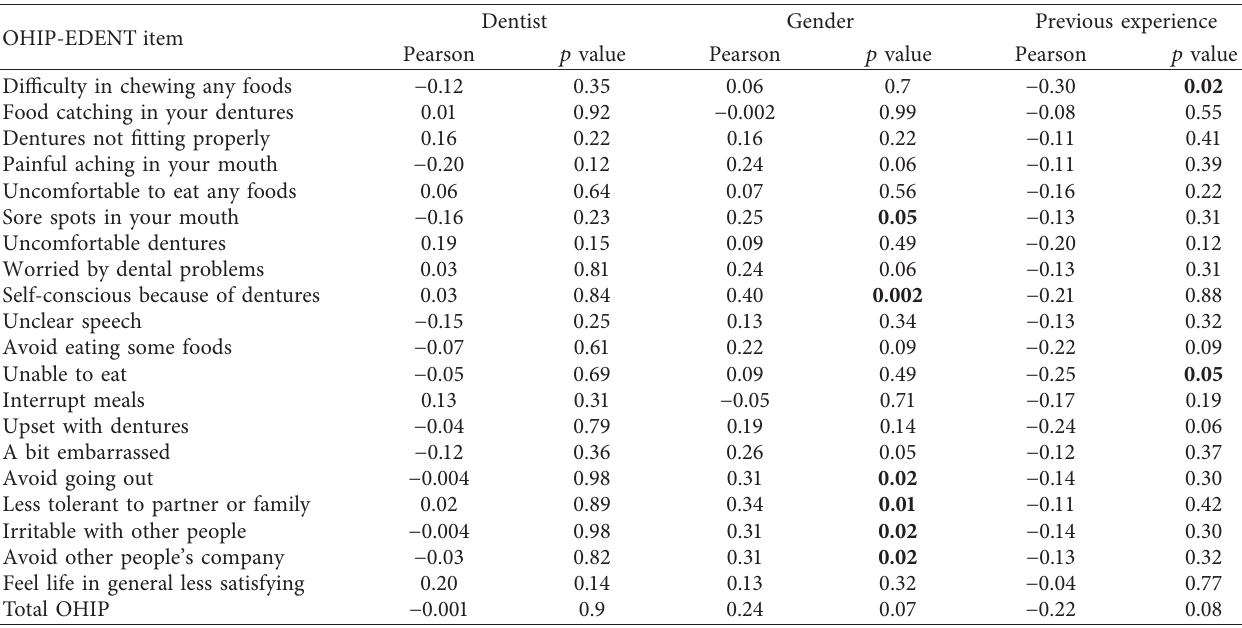
Bold indicates a statistically significant difference between